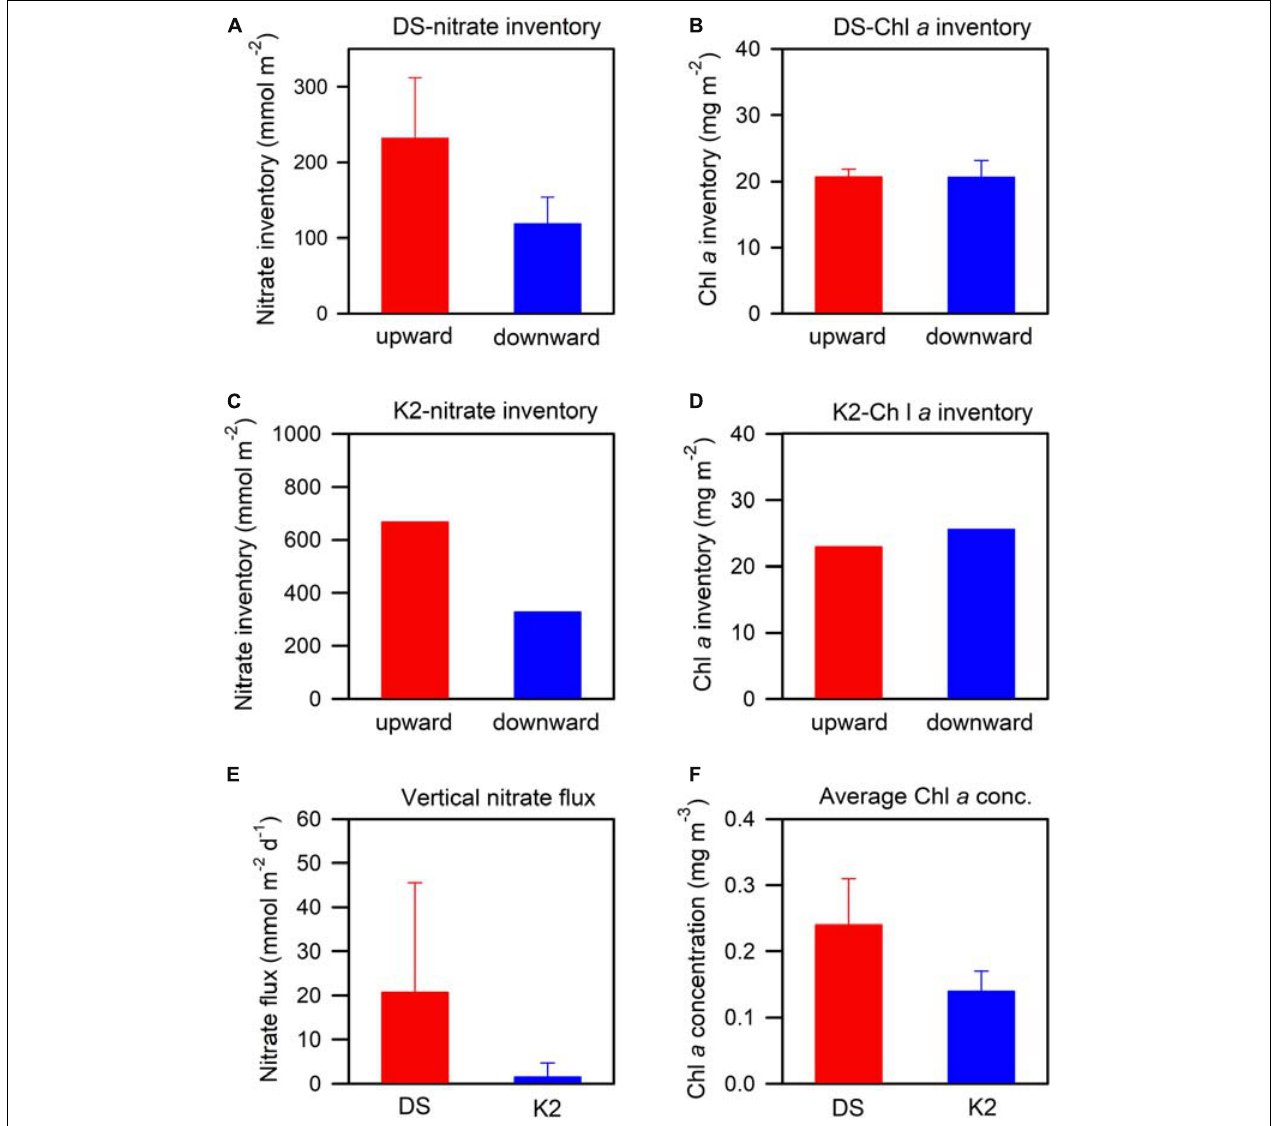
FIGURE 4 | The integrated Chl a and nitrate inventories during the upward (red bar) and downward (blue bar) phases of the isotherm displacements at the DS (A,C) and K2 (B,D) stations, and the average vertical nitrate flux (E) , and average Chl a concentration (F) at the DS and K2